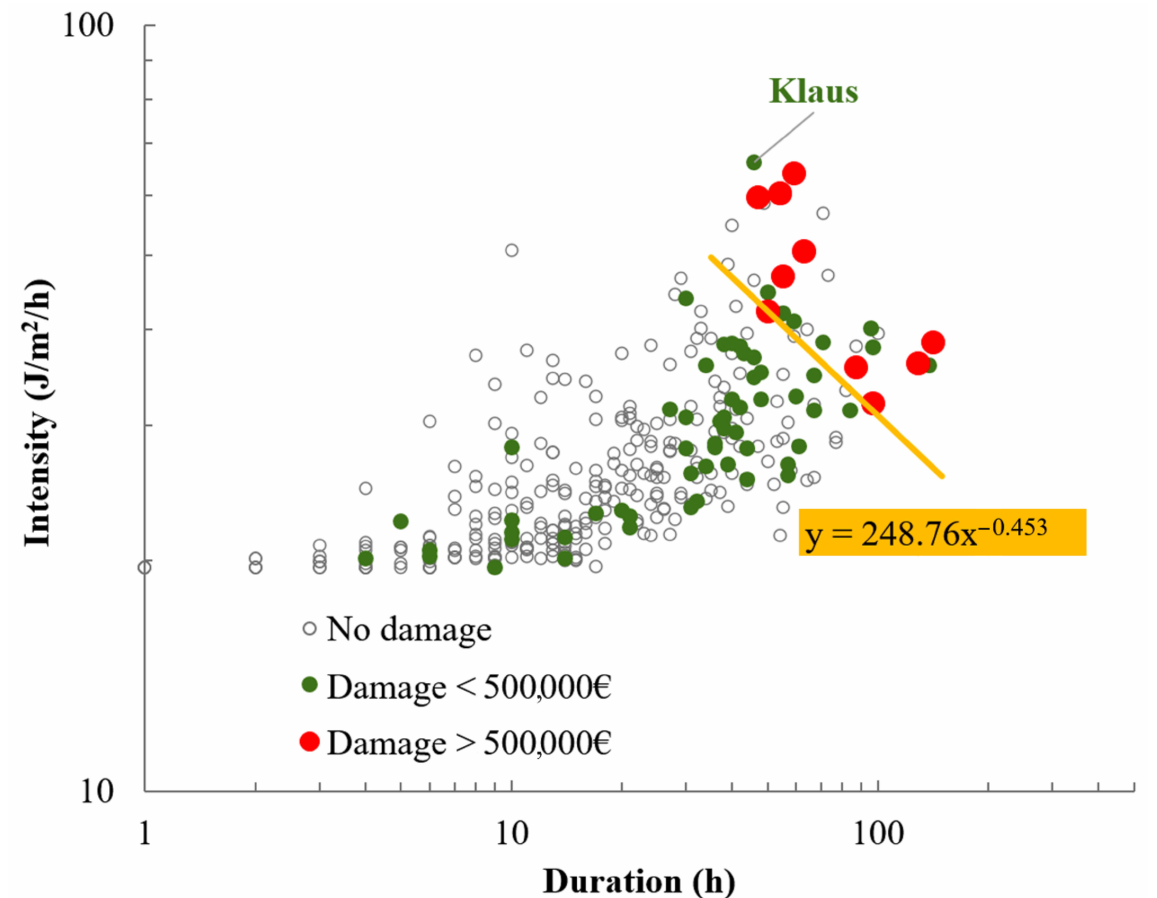
Figure 13. Intensity–Duration Log-Log plot. I-D function shows that increasing the duration decreases the minimum intensity needed to trigger significant economic